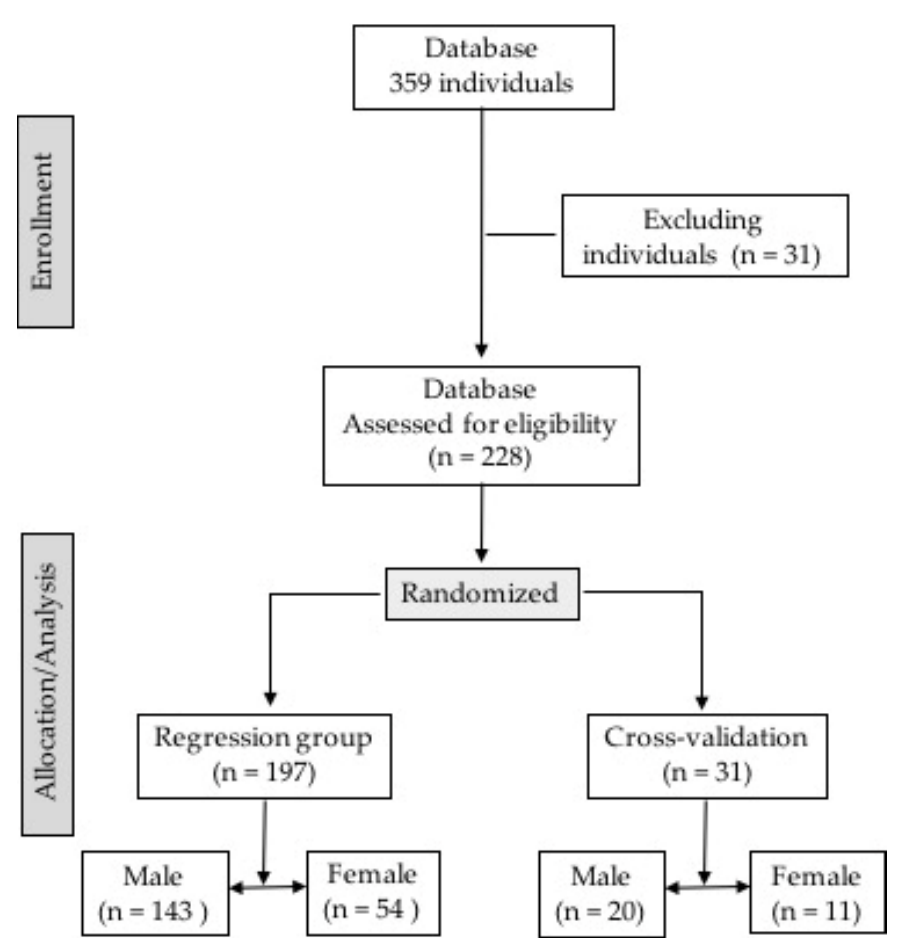
Figure 1. Description of the selection process and randomization of regression and cross-validation groups.